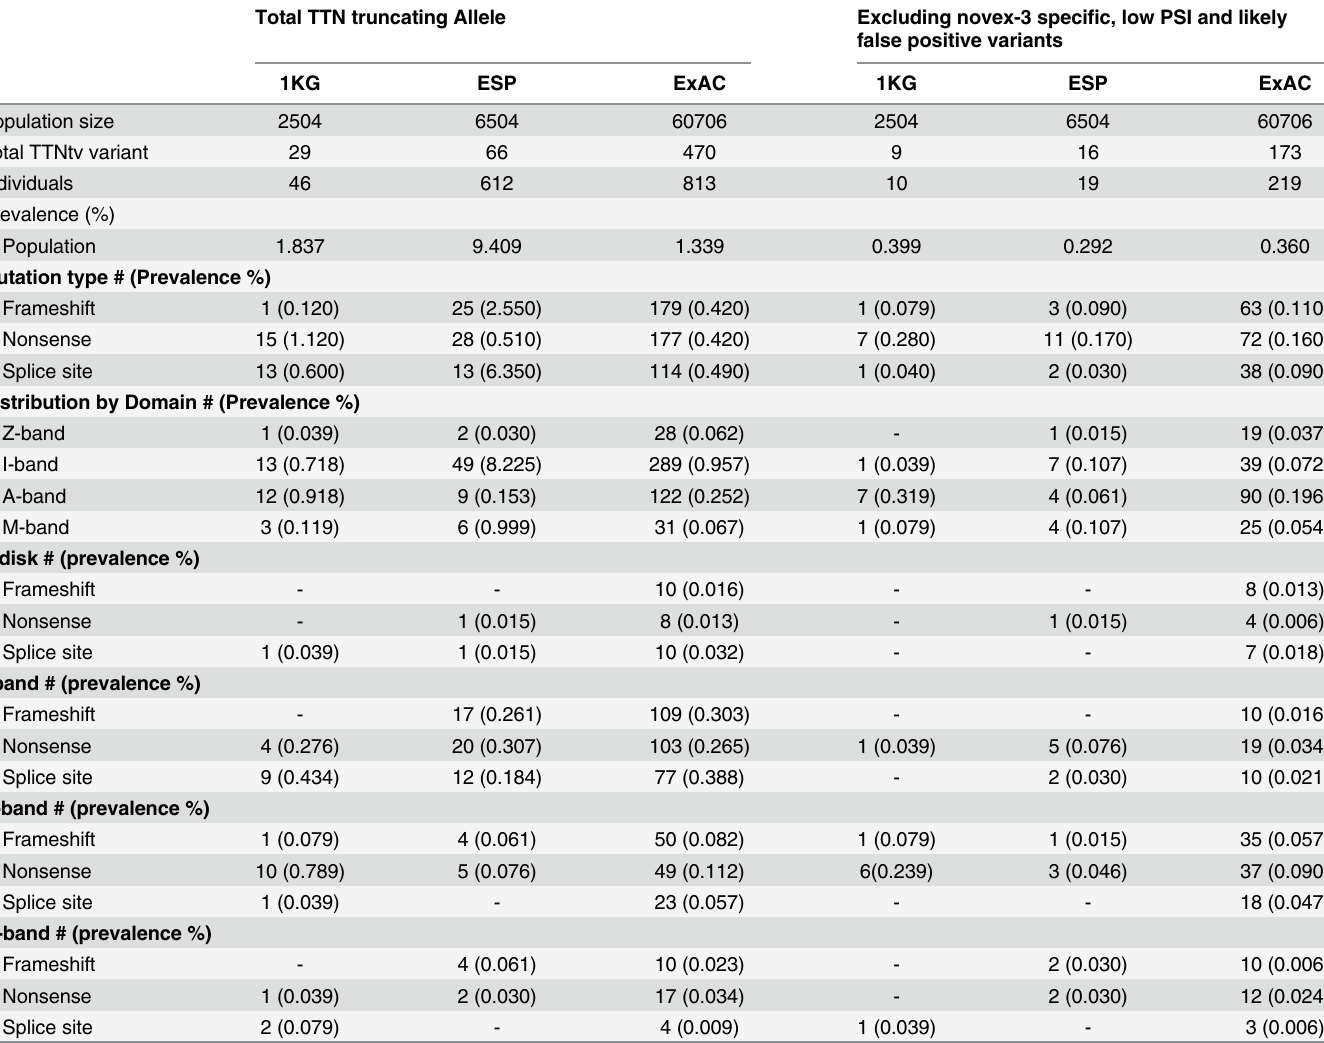
Table 1. Distribution and burden of TTN truncations in publicly available reference